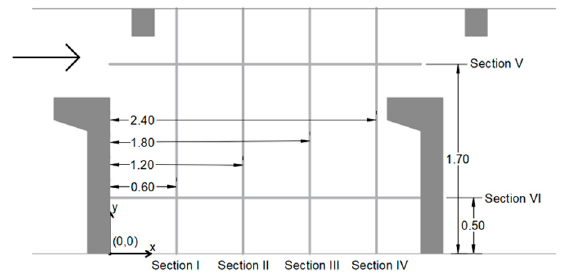
Figure 3. Cross sections I, II, III and IV and vertical planes parallel to the longitudinal axis of fishway sections V and VI used for results analysis (dimensions in meters).